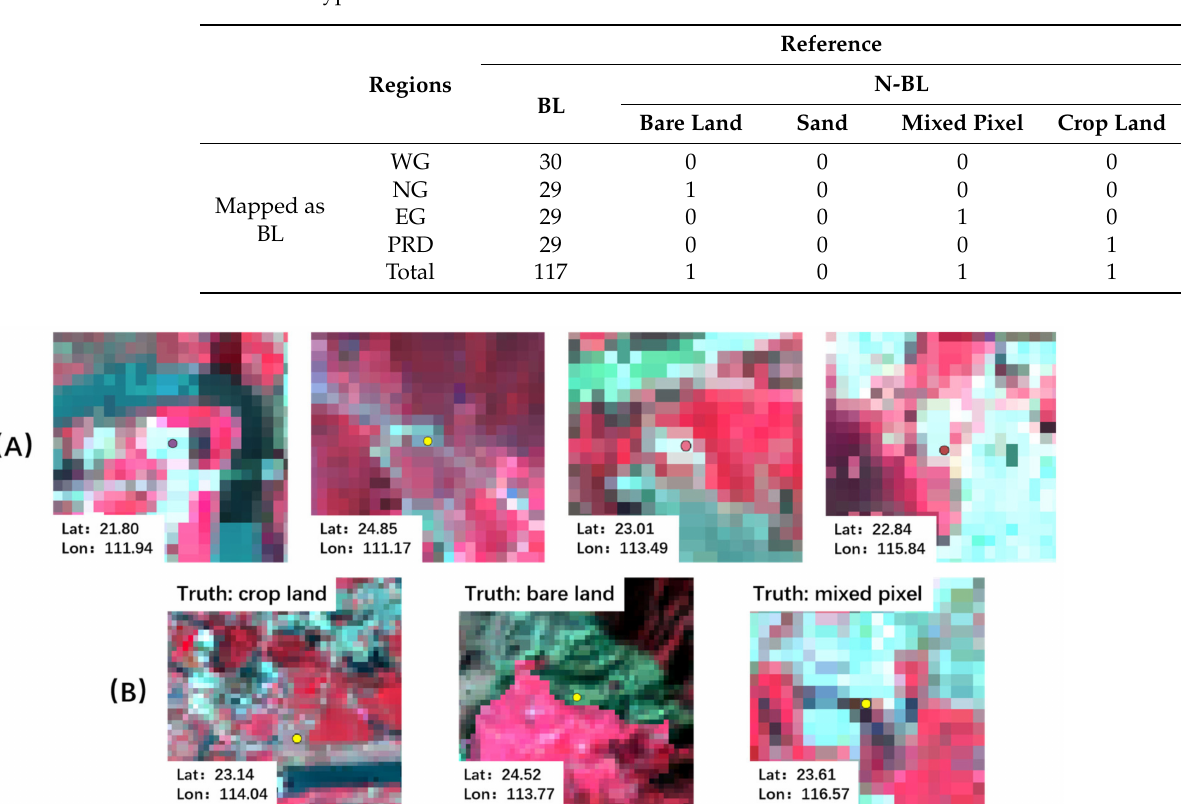
Table 5. Statistical matrix of land use for all commission errors of built-up land in Guangdong in